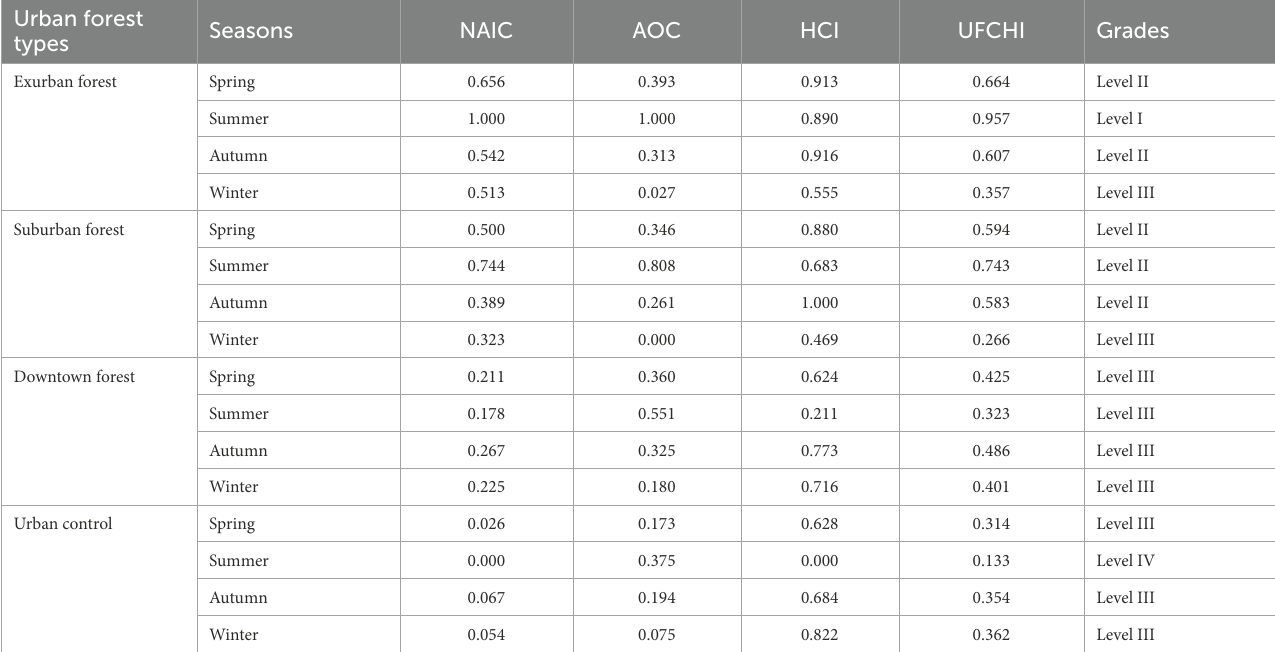
TABLE 7 Indicators’ normalized value of different seasons and their UFCHI. Urban forest